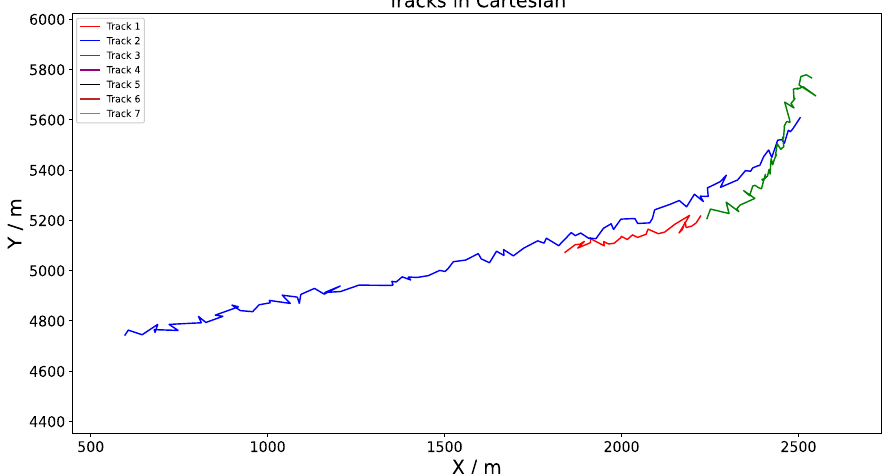
Figure 25. Multi-target tracking in the Cartesian coordinate system (REMTT).